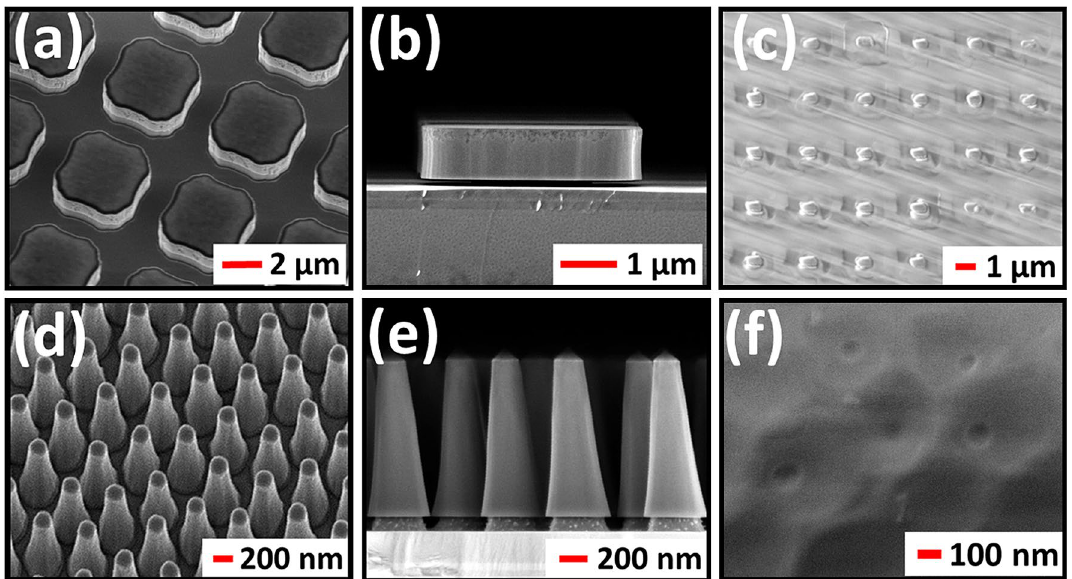
Figure 3. Scanning electron microscopy (SEM) images of the fabricated GaInP structures. ( a – c ): micro-square (MS) and ( d – f ) tapered nanowire (NW) arrays. Representative top view and cross-section (with partially etched GaAs sacrificial layer) images for the structures still on the substrate are included ( a , d ) and ( b , e ), respectively. Top view images for the respective structures embedded in PDMS (after peel-off) are shown in ( c ) and ( f ).